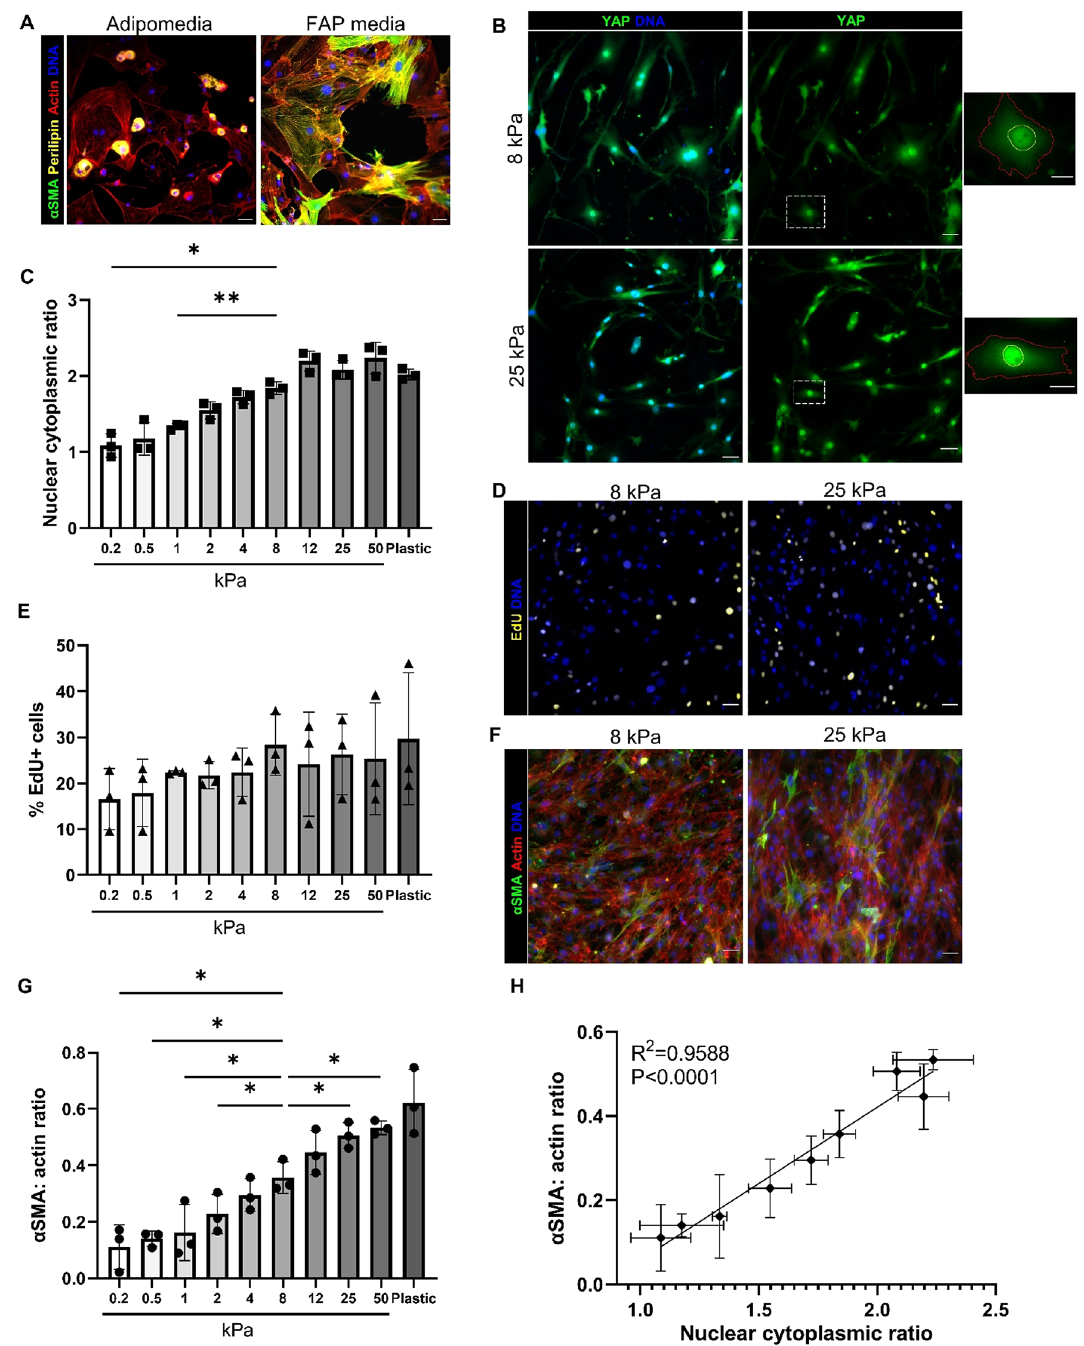
Figure 1. FAPs’ response to substrate stiffness. ( A ) Expression of perilipin and αSMA in FAPs after 7 days in adipogenic or FAP media. ( B ) YAP immunofluorescence of FAPs on polyacrylamide gels on 8 kPa and 25 kPa. Yellow outlines indicate nuclei and red outlines indicate cytoplasm on insets. ( C ) Quantification of YAP signal intensity in nucleus and cytoplasm. ( D, E ) EdU signal and quantification of percent proliferating cells after 24 h EdU treatment ( F ) αSMA signaling as a measure of myofibroblast activation in FAPs. ( G ) Quantification of αSMA and actin area ratio. ( H ) Pearson correlation of αSMA expression and YAP nuclear localization fitted with linear regression line. * P < 0.05, ** P < 0.01, compared to 8 kPa via one-way ANOVA using repeated measures with Dunnett correction. Scales bars set to 50 μm. Scale bars for insets set to 20 μm. N = 3 mice and n = 3 independent